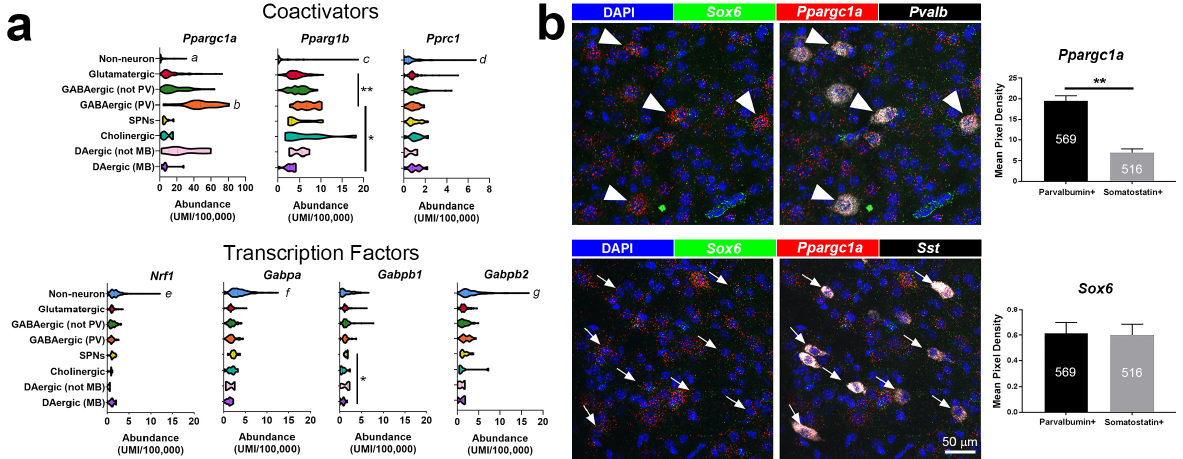
Figure 1. ( a ) A publicly available single-cell transcriptomic dataset [64] was used to explore cell-type-specific mRNA expression abundance in different neuronal populations of the mouse brain. Note the differences in the x-axes scales. ( b ) mRNA abundance for Ppargc1a and the interneuron-specific developmental marker Sox6 was measured in neurons expressing parvalbumin ( Pvalb, white arrowheads) or somatostatin ( Sst, white arrows) mRNA using small molecule fluorescent in situ hybridization [62] in cortex from mice on postnatal day 14 ( n = 3/group, total cell number indicated in white). Kruskal-Wallis analyses were used in (a), with * p < 0.05, ** p < 0.01, and letters indicating other statistically significant differences <0.05. a = different than all but cholinergic and DAergic (MB); b = different than all but cholinergic and DAergic (not MB); c = different than all but DAergic (MB); d = different than glutamatergic, GABAergic (not PV), and GABAergic (PV); e = different than all but SPNs, Cholinergic, and DAergic (MB); f = different than all but SPNs, Cholinergic, and DAergic (not MB); g = different than all but GABAergic (PV), SPNs, DAergic (not MB). Unpaired t-tests were used in (b); 165–208 cells and four representative sections /mouse, three mice; ** p < 0.01. UMI = unique molecular identifier. PV = parvalbumin-expressing neurons. SPNs = spiny projection neurons. MB = midbrain.